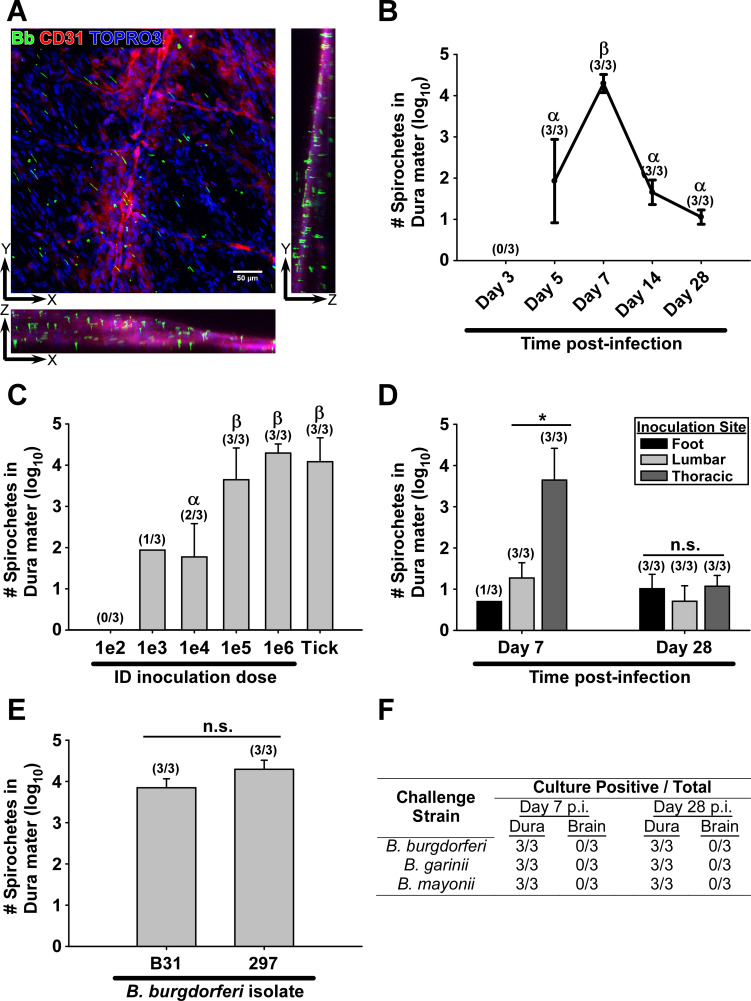
burgdorferi infects the dura ubiquitously during early infection.B. A. Representative confocal z-series showing B. burgdorferi (Bb, green), blood vessels (CD31, red), and nucleated cells (TOPRO3, blue) in the dura mater of C3H mice on day 7 of infection with 106 spirochetes. X-axis rotation (XZ) and Y-axis rotation (ZY) of image are also shown. B. Number of intact spirochetes in the dura mater (log10 mean ± s.d.) at various time points after infection with 106 spirochetes. Symbols α and β indicate statistically different groups (p ≤ 0.003; α = 0.05) as determined by one-way ANOVA followed by all pairwise multiple comparison (Holm-Sidak). C. Number of spirochetes in dura mater (log10 mean ± s.d.) on day 7 of infection using increasing needle inoculation doses as well as tick transmission (10 ticks per mouse). Symbols α and β indicate statistically different groups (0.021 < p < 0.048; α = 0.05) as determined by one-way ANOVA followed by all pairwise multiple comparison (Holm-Sidak). D.
B. burgdorferi burden in the dura (log10 mean ± s.d.) based on site of inoculation (foot, lumbar, thoracic), and duration of infection (day 7, day 28) of mice infected subdermally with 106 spirochetes. Asterisk indicates significant difference as determined using Student’s t-test (p = 0.009; α = 0.05). “n.s” denotes no statistical significance by one-way ANOVA (p = 0.4; α = 0.05). E. Bacterial burden in the dura on day 7 of infection after inoculation with 106
B. burgdorferi strain B31, or strain 297. “n.s” denotes no statistical significance by Student’s t-test (p = 0.07; α = 0.05). In (B-E), Spirochetes were counted in dura mater by systematic counting using f-IHC, epifluorescence microscopy, and gridded coverslips, as described in Materials and Methods and in Fig 1B. Counts shown are normalized to the approximate area of calvaria-associated dura mater after craniotomy (96.5mm2). Number of dura samples with detectable spirochetes / total n are listed for each group above the bar. Conditions with less than two positive dura samples were omitted from statistical analysis. F. Number of isolated dura samples resulting in positive cultures in BSK medium from mice infected for 7–28 days with B. burgdorferi isolate 297, B. garinii, or B. mayonii as determined using darkfield microscopy.